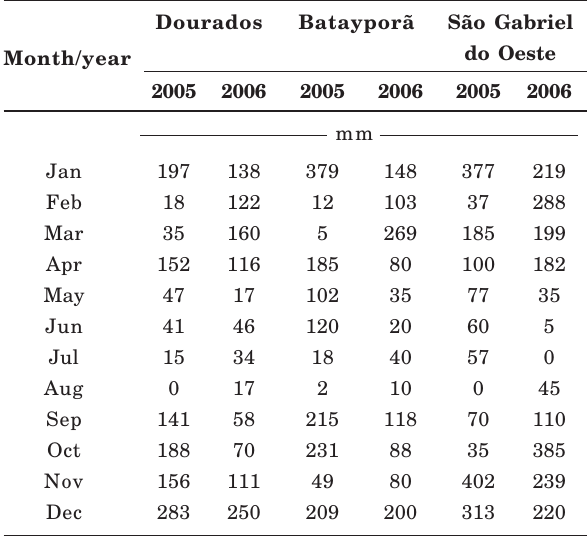
Table 1. Rainfall registered at the three locations during the experiment, in Mato Grosso do